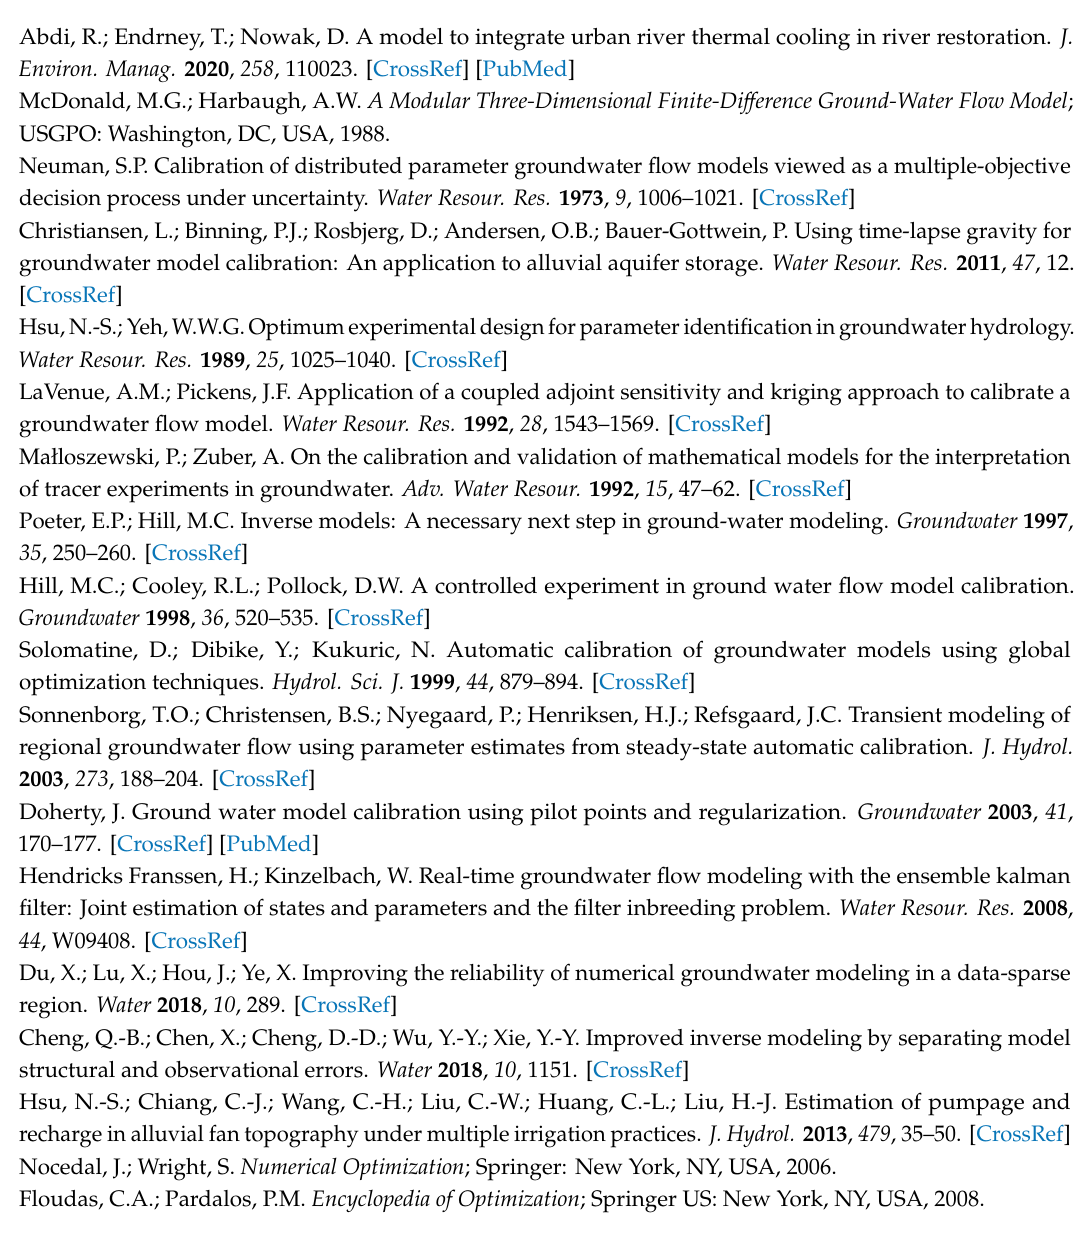
multiple parameter zones, Figure S2. Footprint of iterations vs. hydraulic conductivity in Experiment 1 and Experiment 2 optimized by (a) Jacobian quasi-Newton method; (b) LMA; (c) SR3 VLS quasi-Newton algorithm, Figure S3. PC Rank Depth adoption diagram for identification of recharge during iterations across multiple zones in Experiment 2, Figure S4. Footprint of iterations vs. surface recharge (-1) and boundary recharge (-2) in Experiment 2 optimized by (a) Jacobian quasi-Newton; (b) L–M algorithm; (c) SR3 VLS quasi-Newton